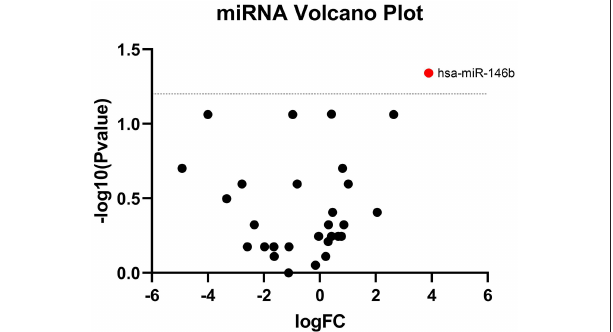
FIGURE 4 | Volcano plot of differential expression of miRNA between patients with and without CVAEs. MicroRNAs are differentially expressed in MM patients treated with CFZ. Volcano plot of significantly up-regulated (red dots) and down-regulated (green dots) microRNAs in patients with and without CVAEs as detected by TaqMan OpenArray profiling. Negative log 10 p -values were plotted on the y-axis, and log 2 normalized fold changes expression levels on the x-axis. A significant differential expression was detected with the p ≤ 0.05.